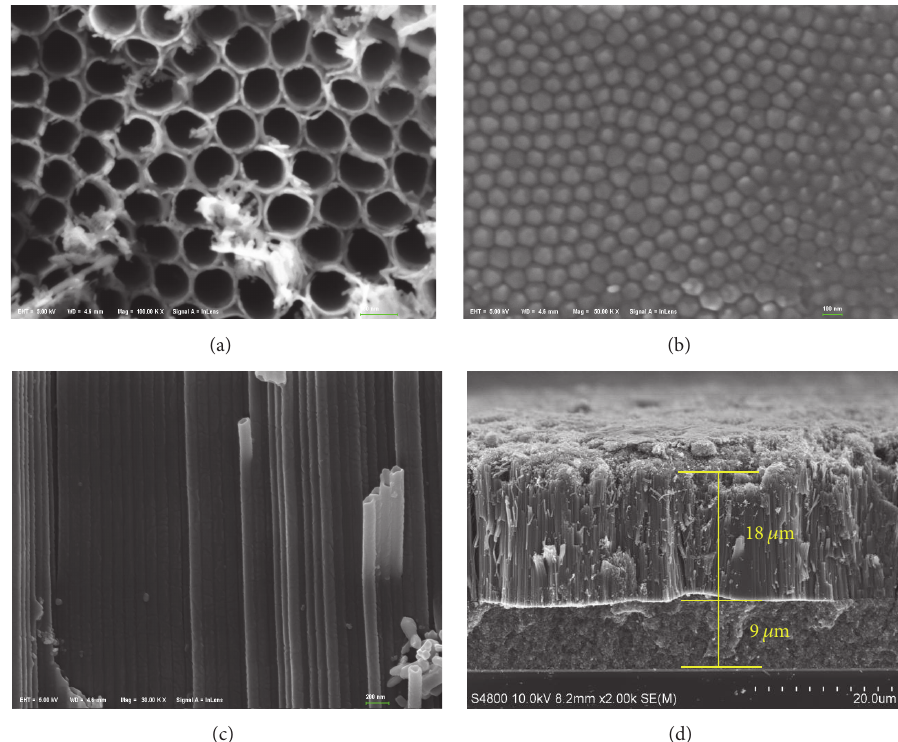
Figure 3: SEM images of TiO 2 nanotube arrays in (a) top view, (b) bottom view, and (c) cross-sectional view; (d) SEM image of double-layer composite film.